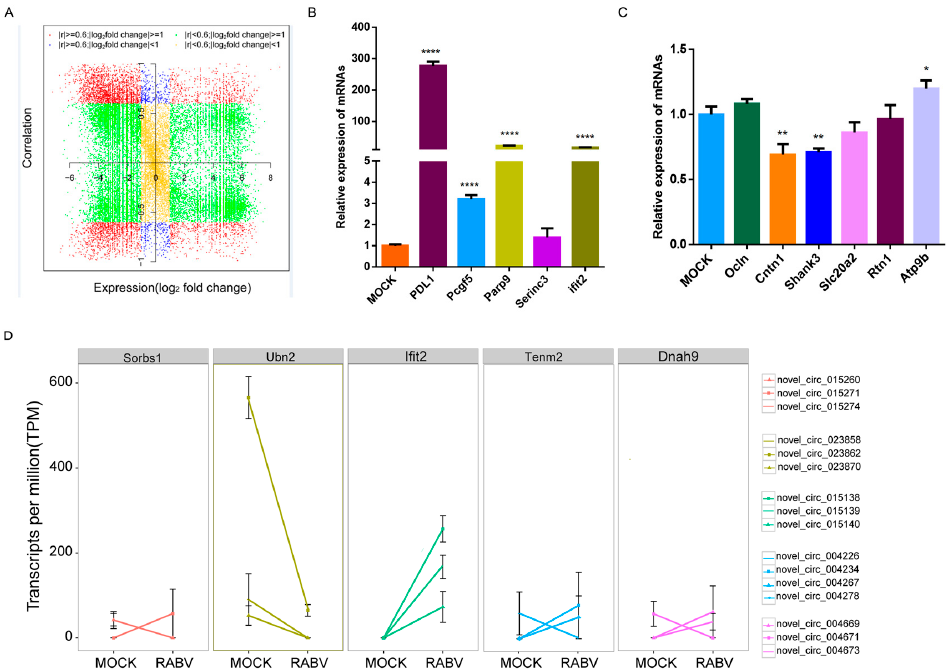
Figure 4. Expression correlation between circRNAs and linear counterparts. ( A ) The expression correlation between circRNAs and corresponding linear transcripts. The circRNAs are colored according to the Pearson correlation coefficient (r) and their expression pattern in RABV infection; ( B ) Expression changes of linear transcripts of six upregulated circRNAs and six downregulated circRNAs ( C ) were tested by RT-qPCR; ( D ) Variable expression patterns of circRNAs derived from Ubn2, Ifit2, Sorbs1, Tenm2, and Dnah9 ( p < 0.05, *; p < 0.01, **; p < 0.0001, ****). As shown in Figure 2H, one gene could generate more than one circRNA. Interestingly, circRNAs originating from the same gene could show a diversified expression pattern (Figure 4D). For example, circRNAs generated from Ubn and Ifit2 showed the same